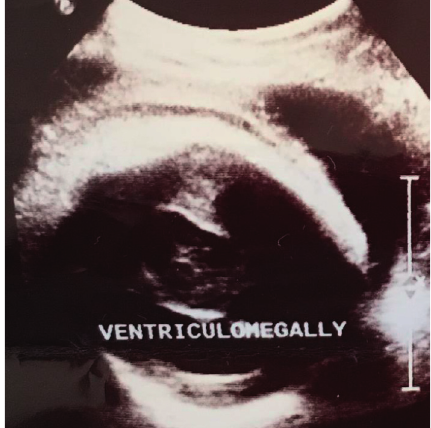
Figure 1: Antenatal ultrasound scan of the fetal head showing a single dilated ventricle with a considerable cortical mantle and a fused thalamus with completely fused hemispheres but without septum pellucidum.